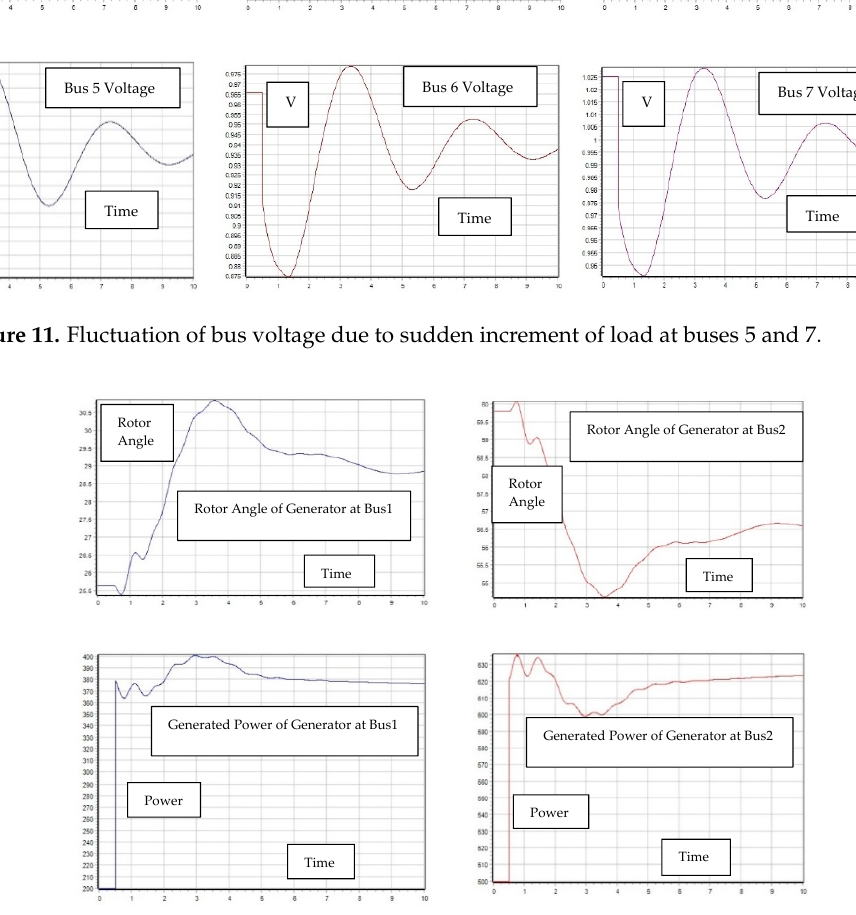
Figure 12. Rotor angle and generated power of generators connected to buses 1 and 2.